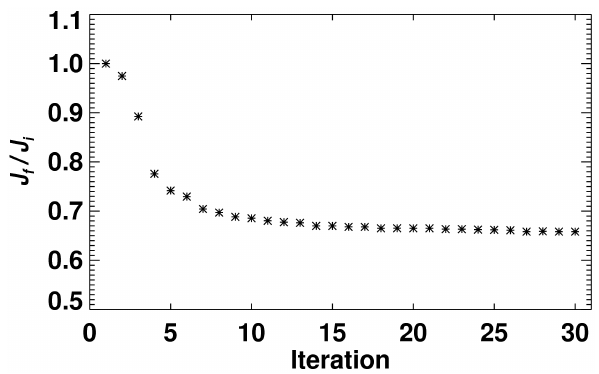
Fig. 4. Cost function evolution for the adjoint optimization using Figure 4. Cost function evolution for the adjoint optimization using TES observations, plotted as 2 TES observations, plotted as the ratio of the final ( J f ) to initial ( J i ) the ratio of the final ( J f ) to initial ( J i ) value for each iteration. 3 value for each iteration. Table 1. Pseudo observation analysis a